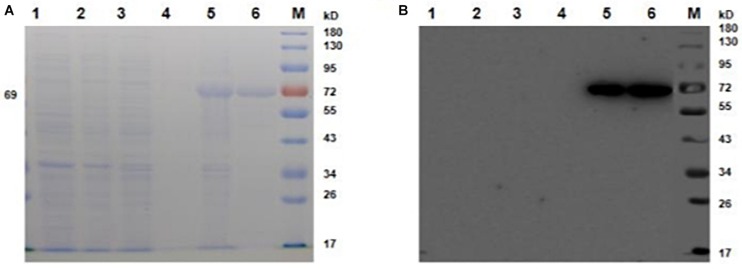
Expression and purification of YbhF. E. coli BL21 cells were transformed with the plasmid pET28a, and the expression of YbhF was induced by IPTG. (A) SDS-PAGE was used to analyze the expression and purification of YbhF. (B) Western blot was used to analyze the expression and purification of YbhF. Primary antibody: Anti-His antibody, secondary antibody: HRP-labeled goat anti-mouse IgG. M: Prestained Protein Ladder, (1) Before induction of E. coli/pET28a. (2) After induction of E. coli/pET28a. (3) Before induction of E. coli/pET28a-ybhF whole cells. (4) Supernatant after induction of E. coli/pET28a-ybhF whole cells. (5) Precipitation after induction of E. coli/pET28a-ybhF whole cells. (6) Purified YbhF protein.